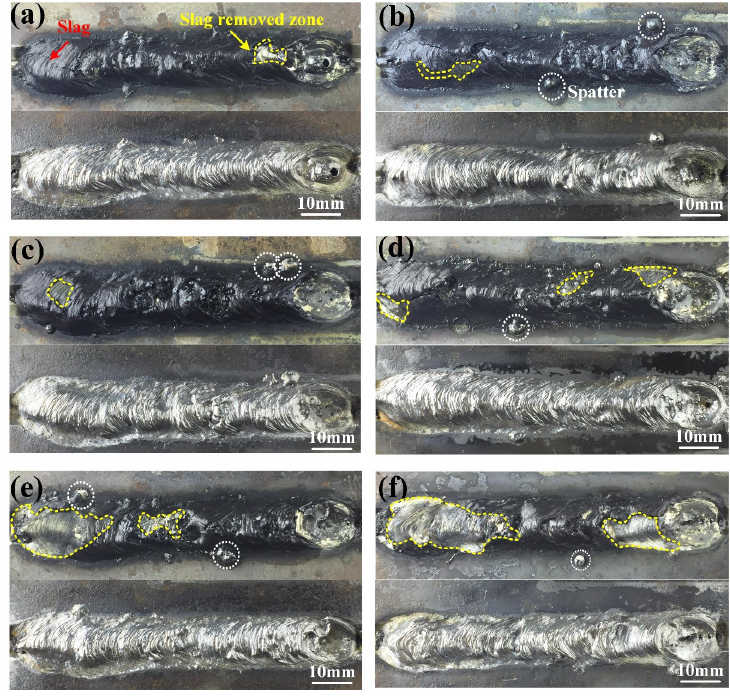
Figure 5. Weld appearances before and after the deslagging at di ff erent conditions: ( a ) without ultrasonic; ( b – f ) ultrasonic output power were 20%, 40%, 60%, 80%, and 100% of the maximum power (1200 W),